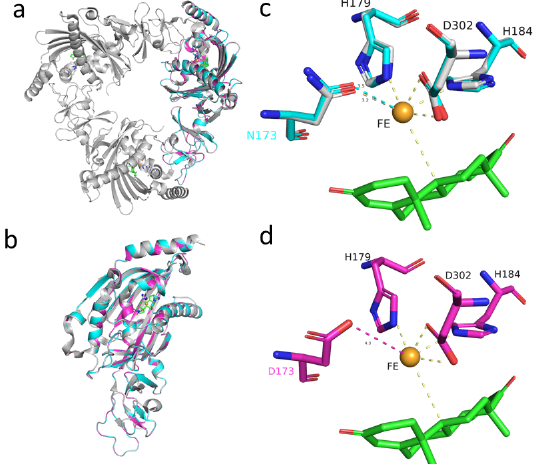
Figure 6. Structure model of KshA1. DSM 1381_ KshA1, pink; DSM 44074_KshA1, blue; structural template, gray; substrate AD, green; the non-heme Fe2+, gold ( a , b ). The residues within 4 Å of Fe are shown in sticks ( c , d ).